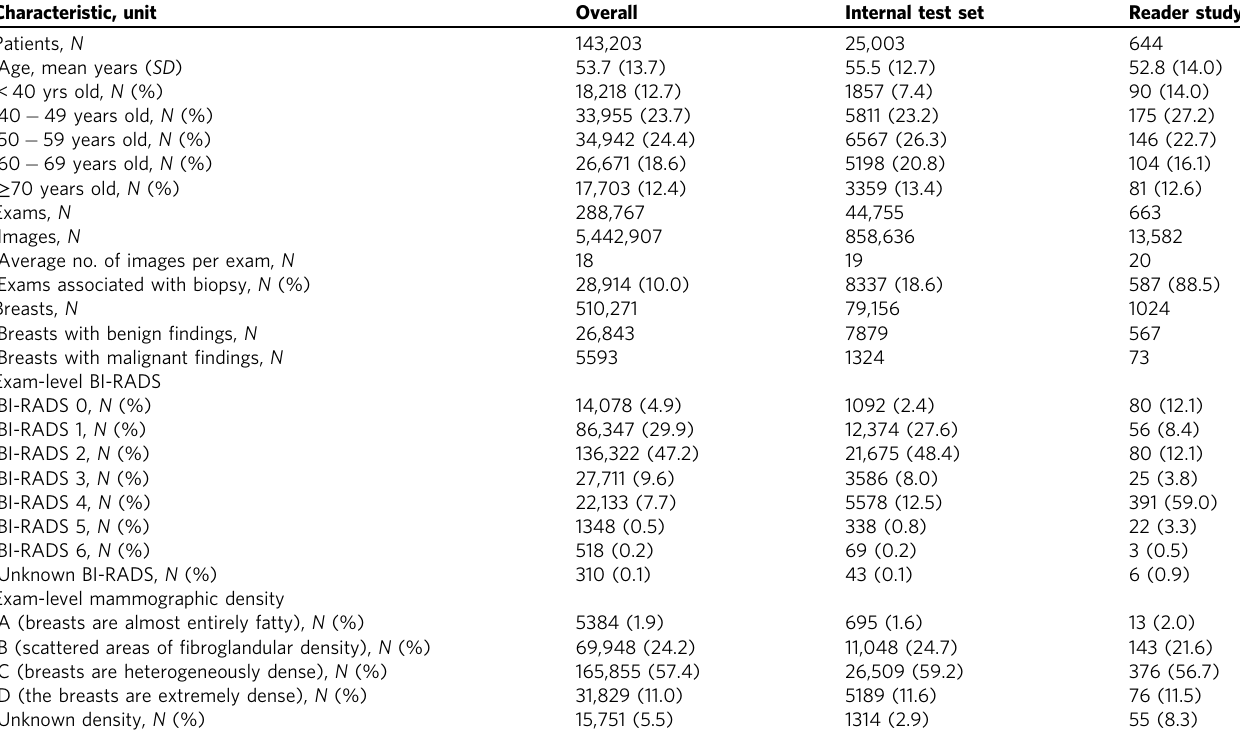
Table 1 Statistics of the overall NYU Breast Ultrasound Dataset, internal test set, and reader study set. This dataset was collected from NYU Langone Health over an eight-year period. Exam-level BI-RADS were issued by radiologists based on patients ’ breast US exams. Breast densities were determined using existing screening and diagnostic mammography reports. Patients who were not matched with any mammograms were assigned "unknown ” for breast density. Abbreviations: N, number; SD, standard